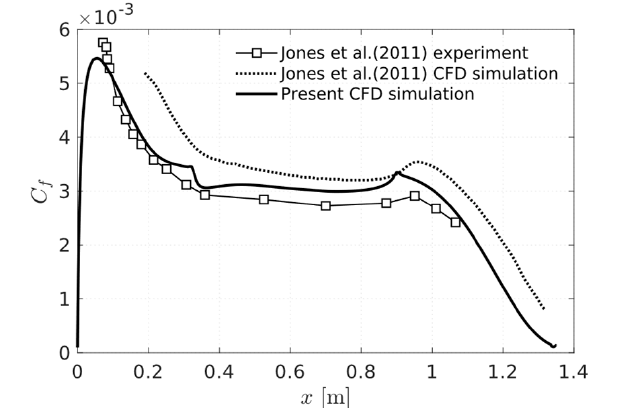
Figure 11. Skin friction coefficient along the model submarine hull from present simulation and experimental measurements by Jones et al. [17].